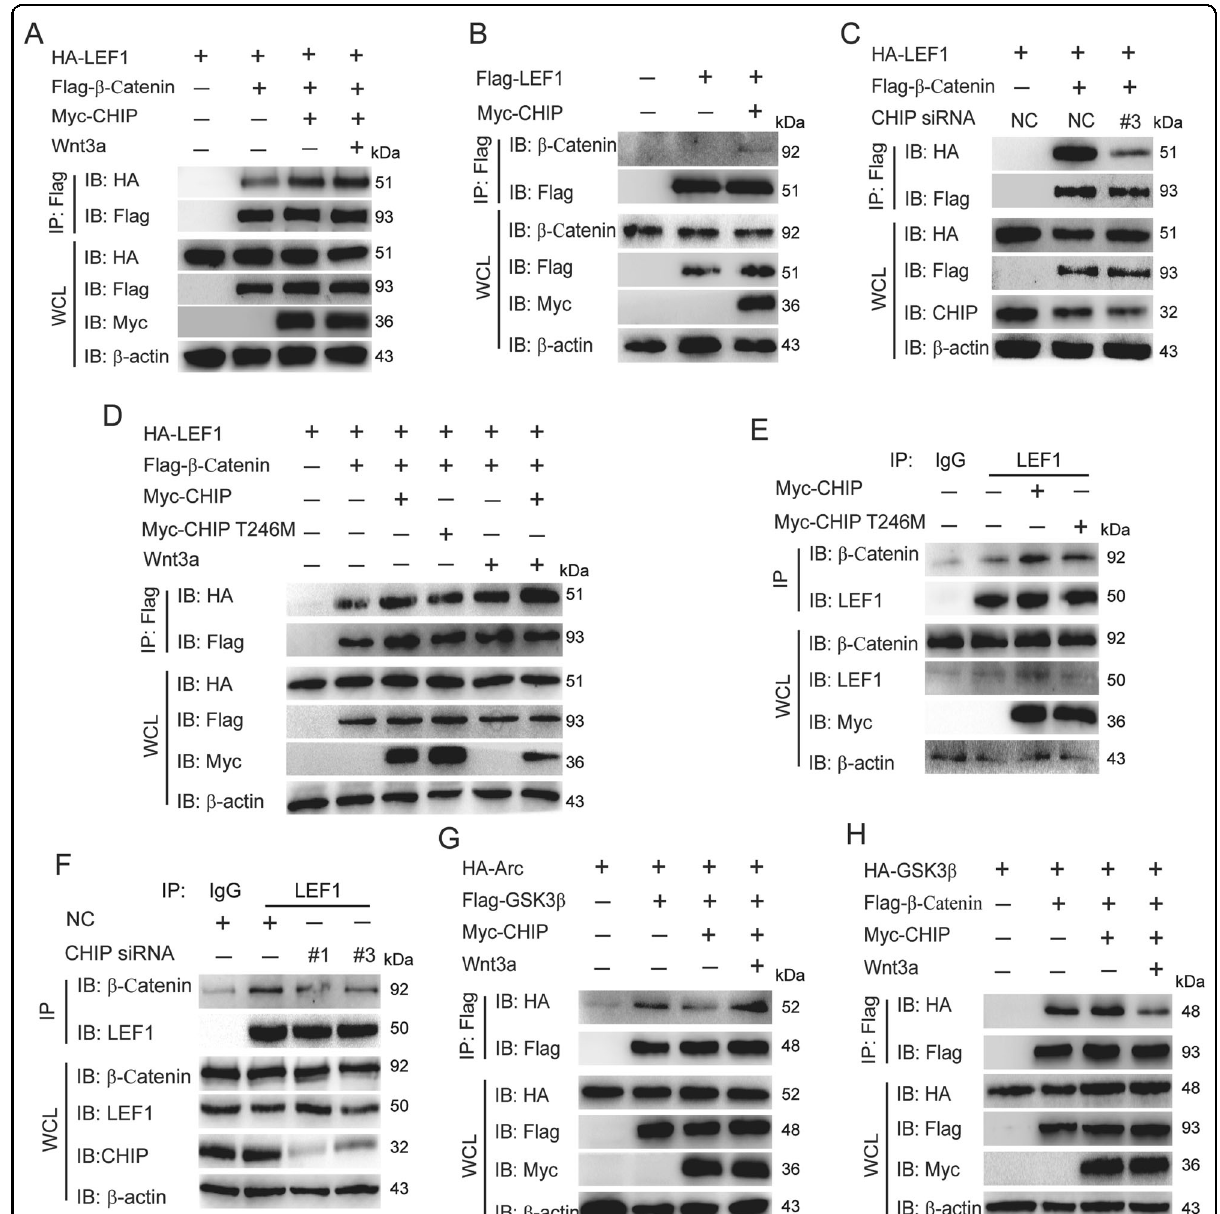
Fig. 5 CHIP in fl uences the interactions between β -catenin and LEF1 or GSK3 β , as well as GSK3 β and Arc. A CHIP enhanced the interaction between β -catenin and LEF1. Immunoprecipitation and immunoblot analysis of HEK293T cells which were transfected with HA-LEF1, Flag- β -catenin, and Myc-CHIP, and stimulated with Wnt3a (40 ng/ml) for 1 h. B – D HEK293T cells were transfected with indicated plasmids or CHIP-speci fi c siRNA as fi gures shown. Whole cell extracts were immunoprecipitated with anti-Flag beads and blotted with anti-HA antibody. CHIP heightened the endogenous interaction between β -catenin and LEF1 ( B ). Knockdown of CHIP reduced the interaction between β -catenin and LEF1 ( C ). The inactive mutant of CHIP could not enhance the interaction between β -catenin and LEF1 ( D ). E – F Immunoprecipitation and immunoblot analysis were performed to detect the endogenous interaction between β -catenin and LEF1. The indicated plasmids or CHIP-speci fi c siRNA were transfected as fi gures shown in SHSY5Y cells. Overexpression of CHIP enhanced ( E ), while knockdown of CHIP reduced ( F ) the endogenous interaction between β -catenin and LEF1. G – H HEK293T cells were transfected with various combinations of plasmids including HA-Arc, Flag-GSK3 β ( G ), HA-GSK3 β , Flag- β -catenin ( H ), and Myc-CHIP, or Myc-CHIP T246M, and stimulated with Wnt3a (40 ng/ml) for 1 h. Immunoprecipitation and immunoblot analysis of CHIP regulated the interaction between GSK3 β and Arc or β -catenin. All results were representative of three independent experiments.